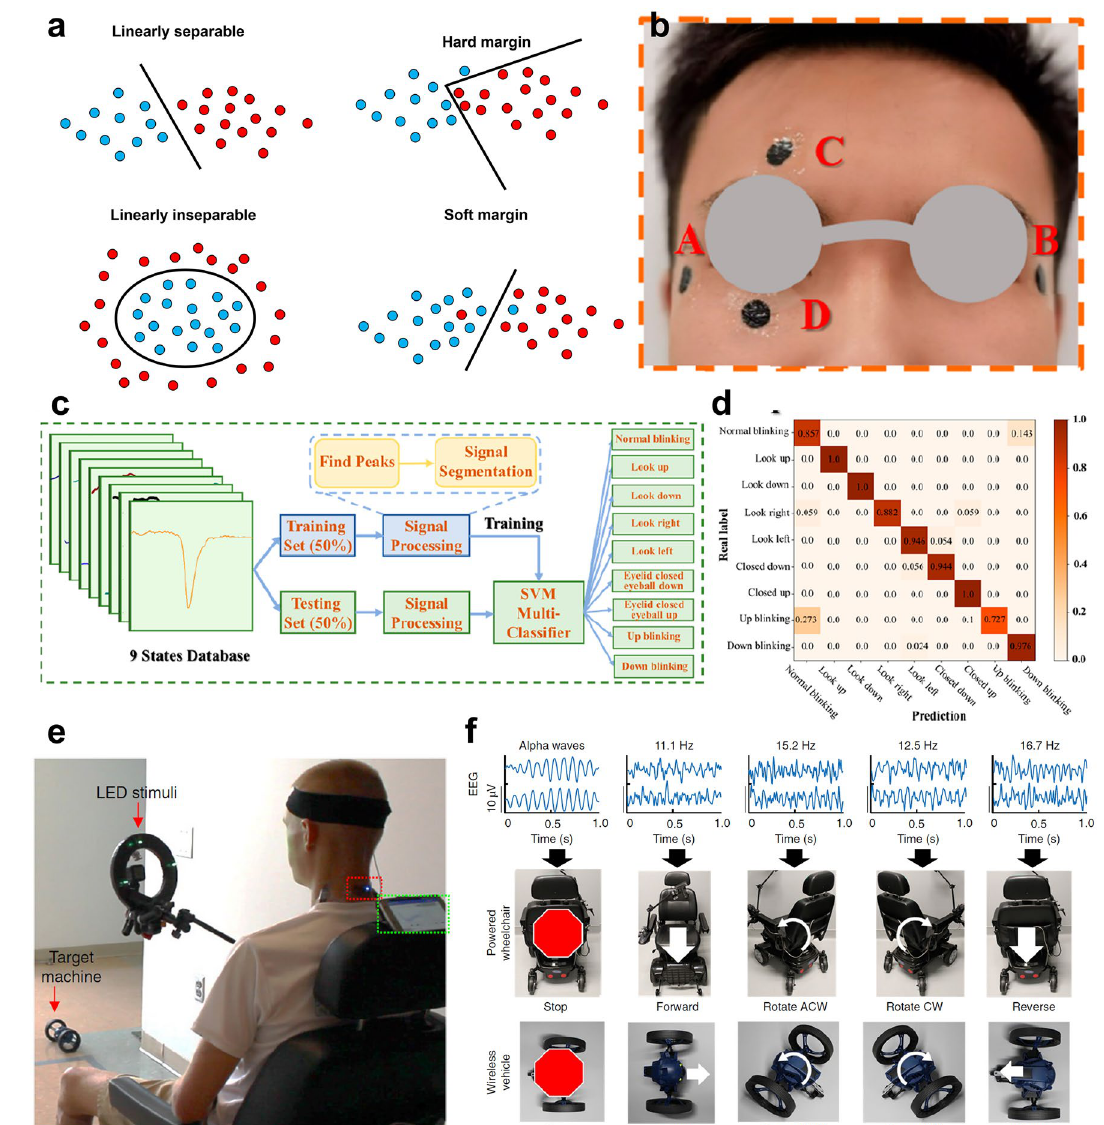
Fig. 19 Signals detected by the soft system and processed by SVM. a Schematic diagram of SVM. b Position of honeycomb graphene elec- trodes attached around eyes of tester. c Flow chart of the SVM algorithm for eye movement classification. d Confusion matrix of SVM clas- sification training recognition accuracy. Reproduced with permission [314]. Copyright (2022), American Chemical Society. e A tester seated in a powered wheelchair with the LED stimulus array in front of the tester. f EEG data recorded at each state, labeled as alpha rhythms, 11.1, 15.2, 12.5, and 16.7 Hz SSVEPs respectively, which corresponds to different commands. Target machines to be controlled by SSVEPs signals, includ- ing a wireless electric wheelchair with five classes (no action, forward, rotate anticlockwise, rotate clockwise, and reverse), and a wireless vehi- cle with the same commands as the wheelchair. Reproduced with permission [32]. Copyright (2019), Springer